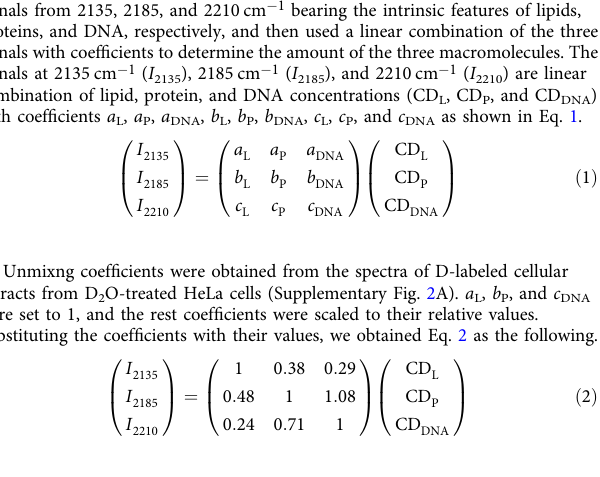
Thus we obtained the unmixing Eqs. 8, 9 for tumor tissues.